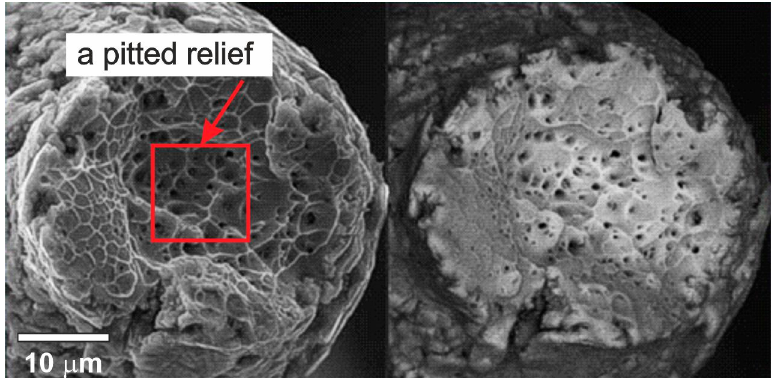
Figure 9. The fracture surfaces of a 40 µm thick NiTi wire.